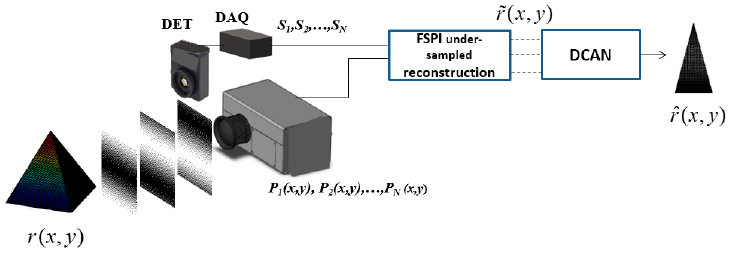
Figure 10. DL-FSPI experimental setup.